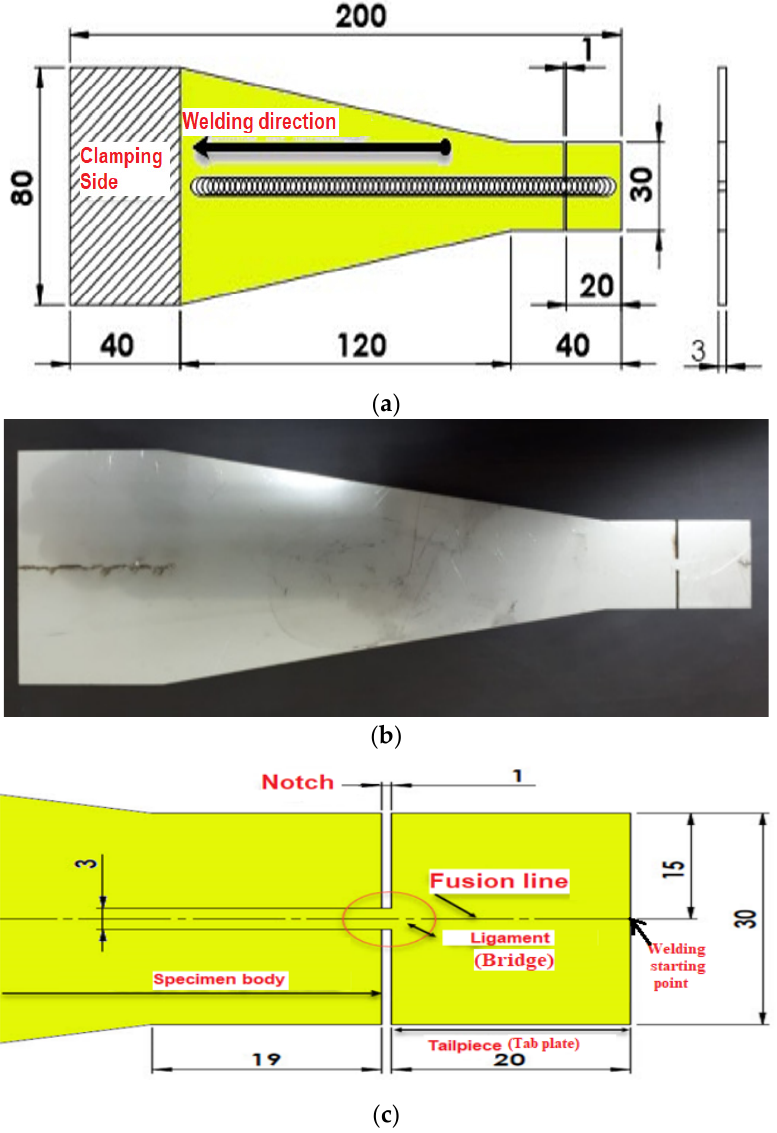
Figure 1. Trapezoidal specimen ( a , b ) and tailpiece (Tab plate) details ( c ). Dimensions in mm.